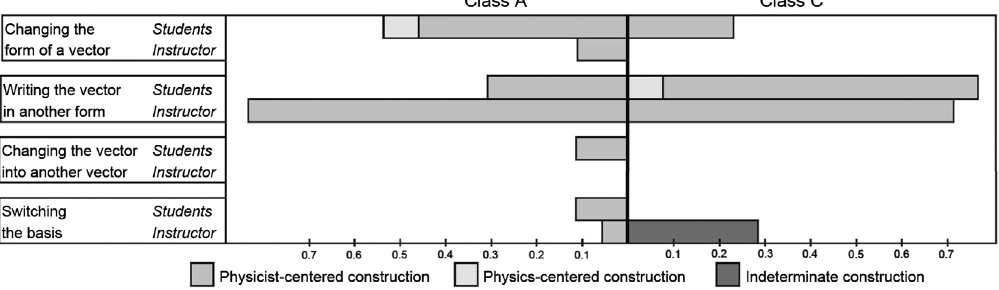
FIG. 3. Proportions of students ’ and instructors ’ discourse referring to change of